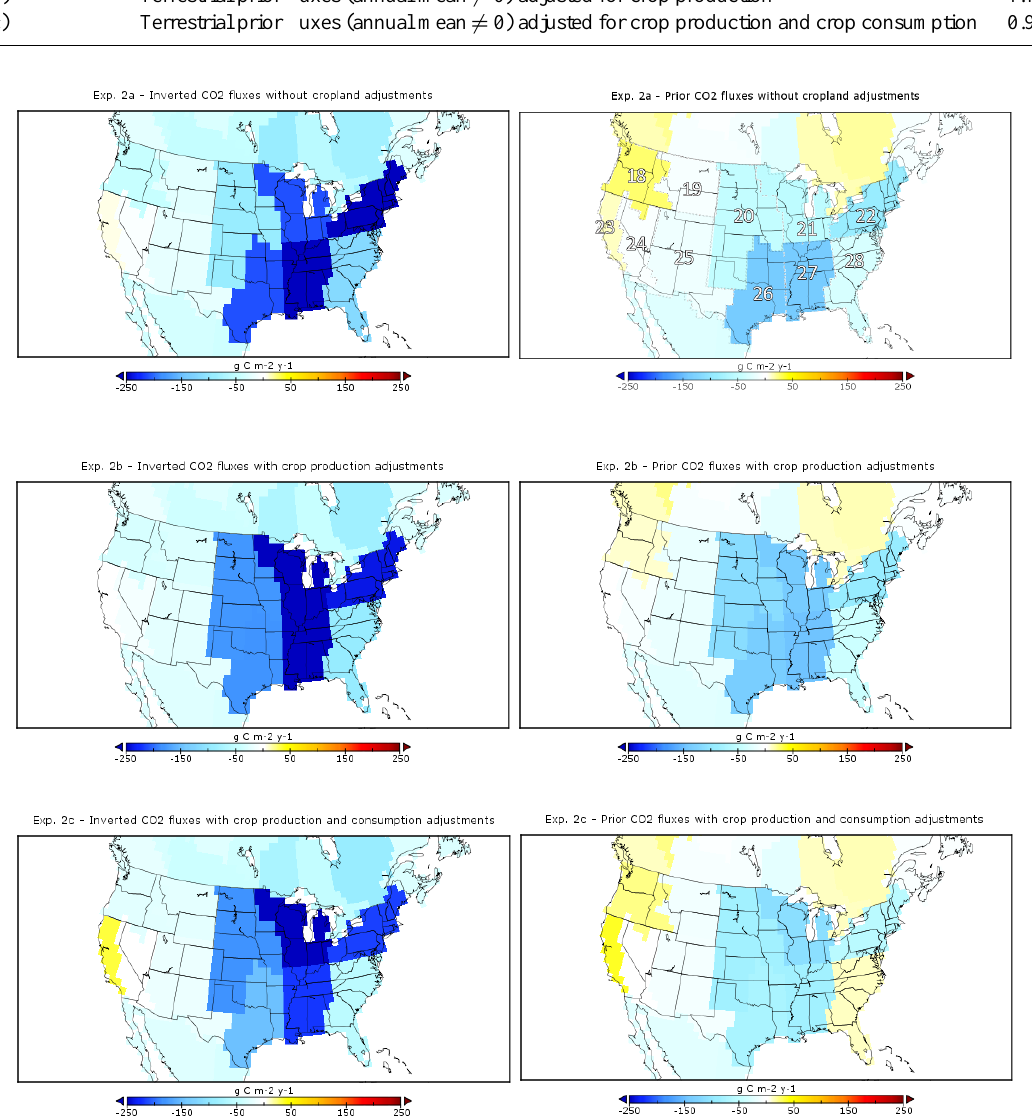
Figure 4. Map of mean annual inverted (left) and prior (right) CO 2 flux for experiment 2 during 2002 to 2007 over the contiguous US. Negative values represent carbon